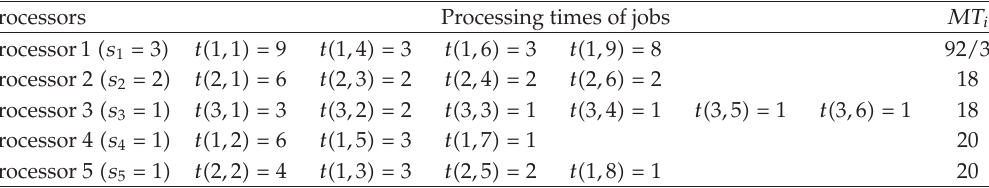
Table 3: The improved LS schedule.